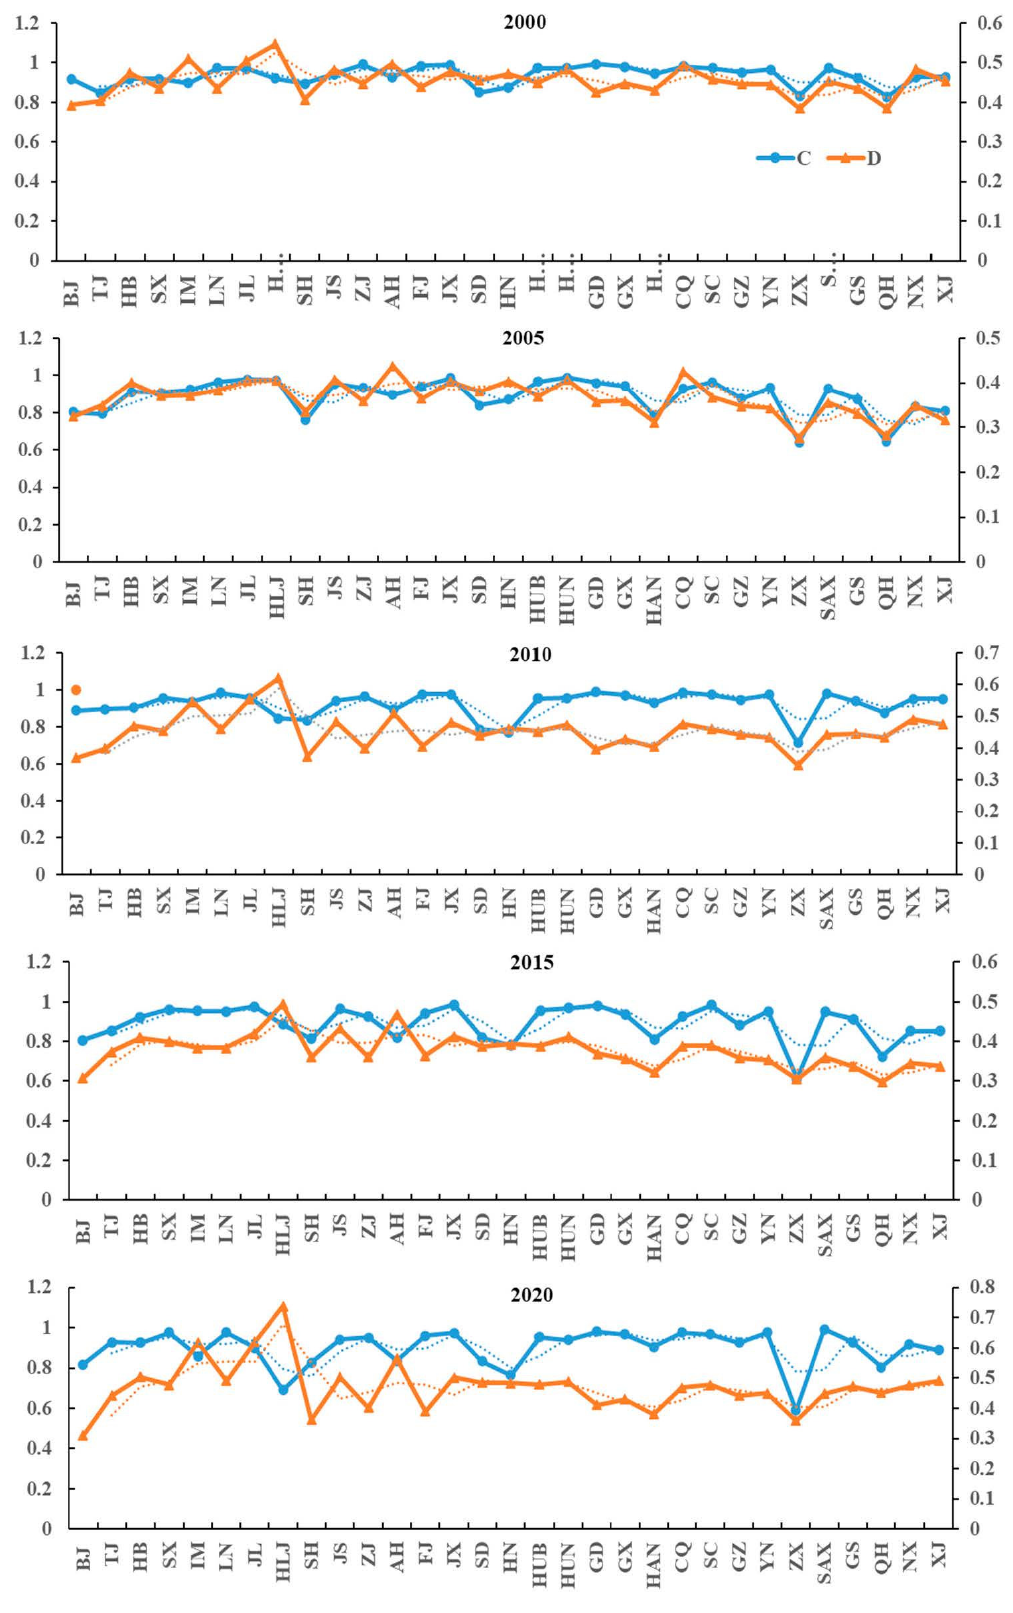
Figure 10. Development trend of coupling degree and coupling coordination degree of “Water–Land–Food–Carbon”.